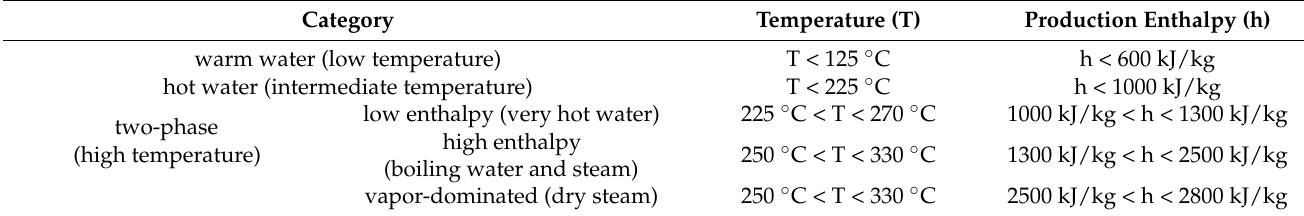
Table 1. Example of geothermal resource allocation